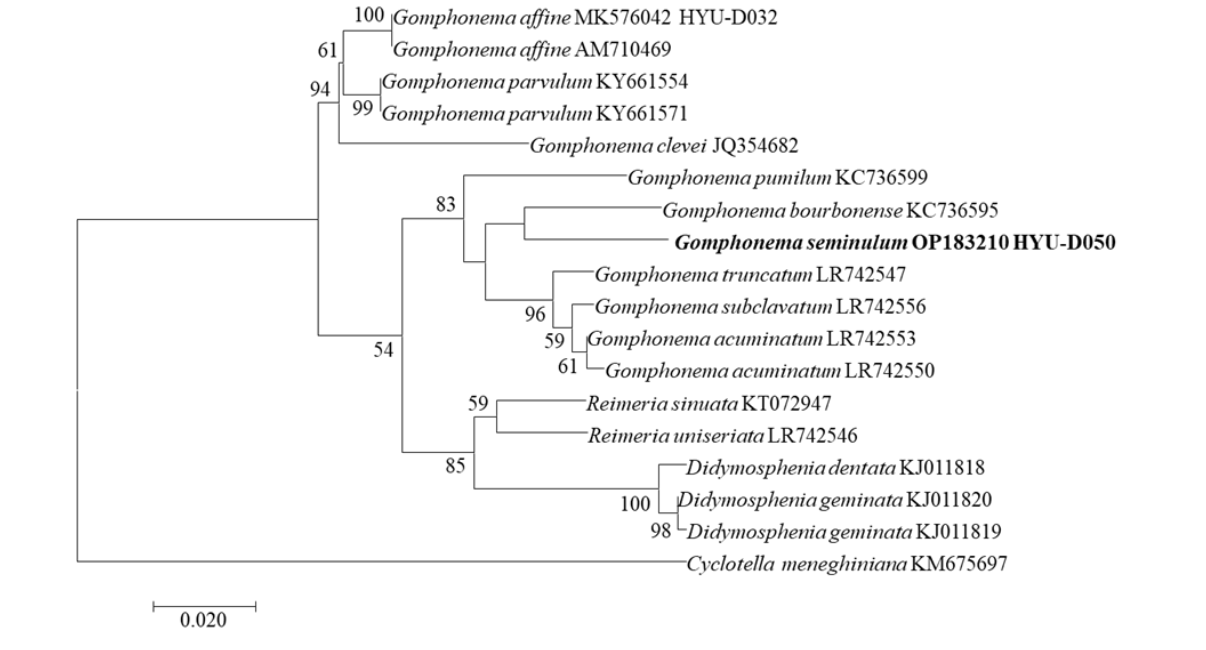
Figure 9. rbcL phylogenetic tree by maximum likelihood method of Gomphonema seminulum sp. nov. and other species molecular position. The tree with the highest log likelihood ( − 1964.35) is shown. The percentages of trees in which the associated taxa clustered together are shown next to the branches. The analysis involved 18 nucleotide sequences and 596 positions in the final data set. Cyclotella meneghiniana was used as the outgroup. Table 6. Similarity scores and genetic distances among 15 aligned sequences (1475 bp) of Gomphonema species based on SSU rRNA gene.